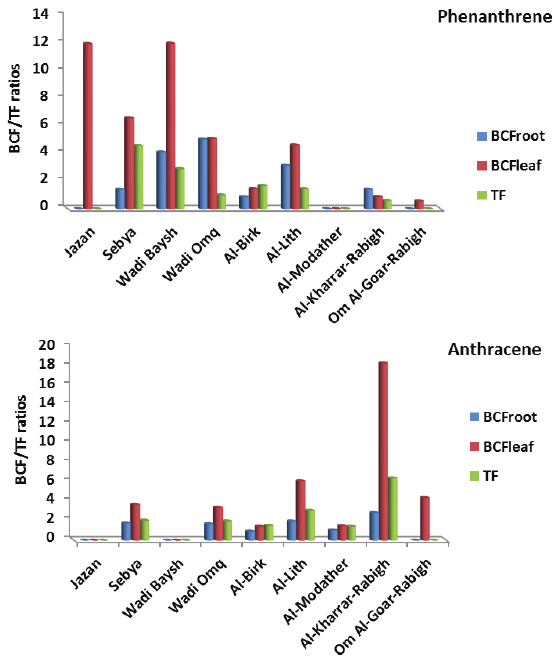
Figure 3: Bio-concentration factors (roots and leafs) and translocation factors for phenanthrene and anthracene in mangrove plants in the study